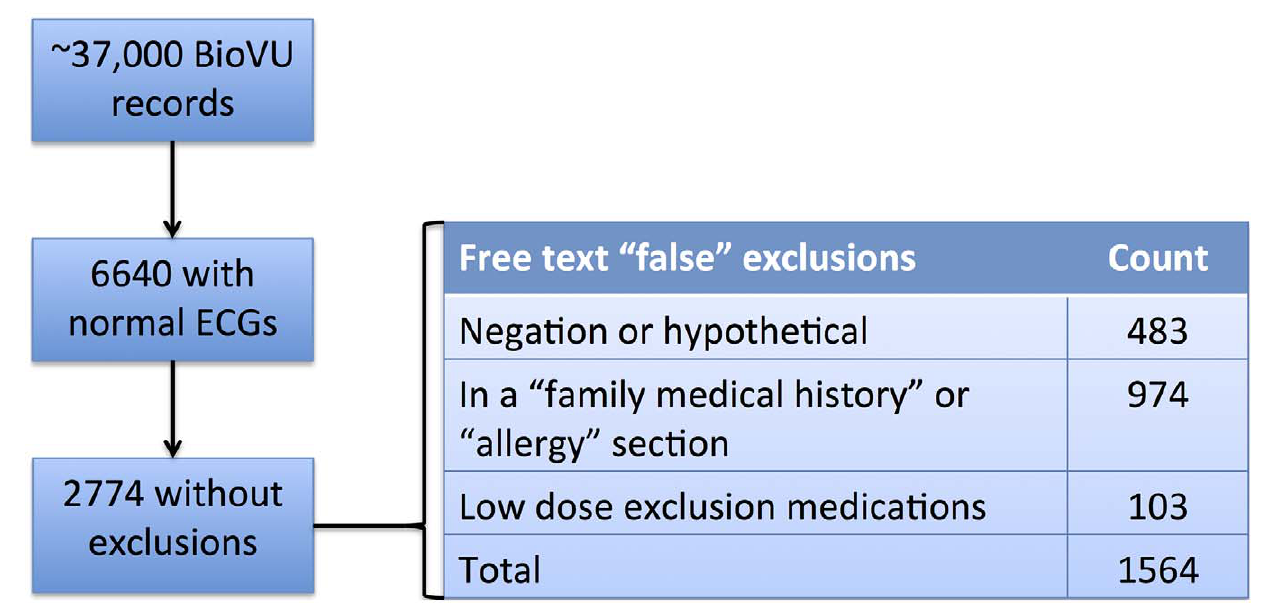
Figure 4. Use of NLP to identify patients without heart disease for a genome-wide analysis of normal cardiac conduction. Using simple text searching, 1564 patients would have been eliminated unnecessarily due to negated terms, family medical history of heart disease, or low dose medication use that would not affect measurements on the electrocardiogram. Use of NLP improves recall of these cases without sacrificing positive predictive value. The final case cohort represented the patients used for GWAS in [71].